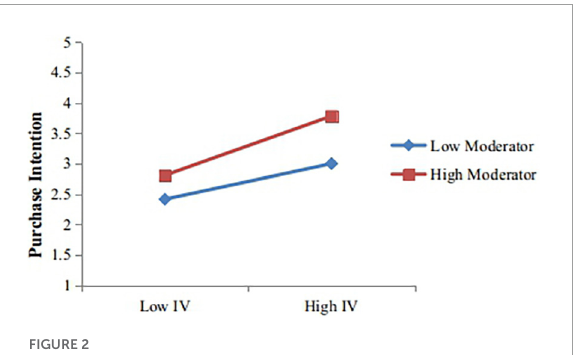
FIGURE2 Moderating effect of green